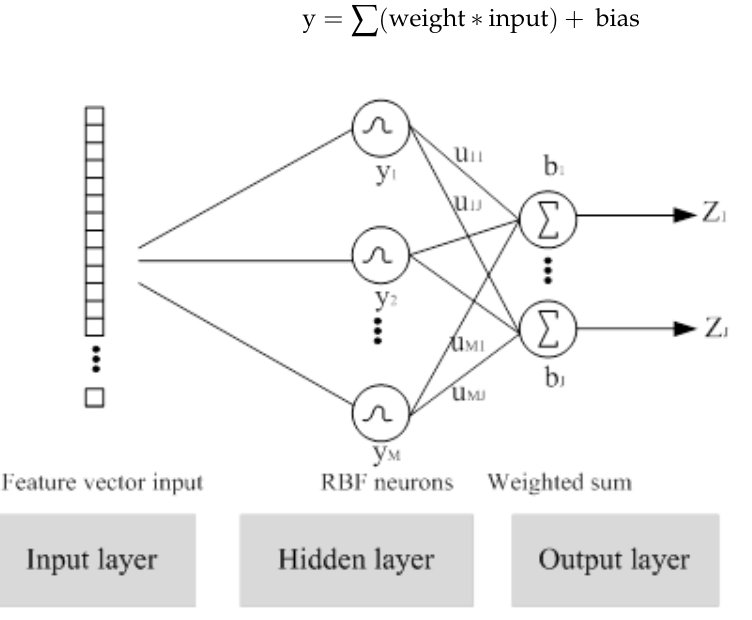
Figure 3. Typical architecture of an RBF neural network.